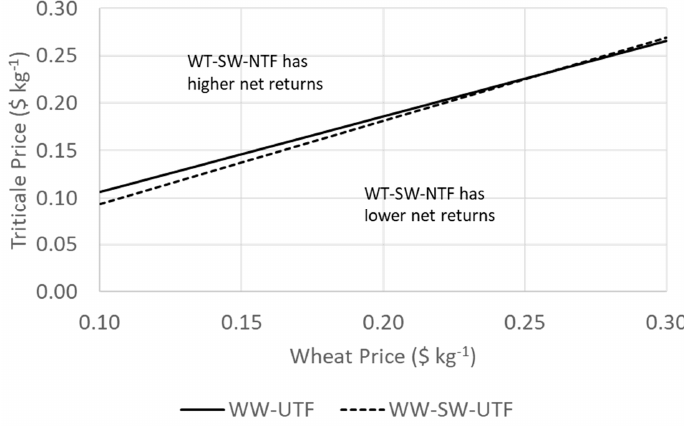
Figure 1. Breakeven winter triticale price as related to wheat price for the WT-SW-NTF rotation to be as profitable as the winter wheat (WW)- spring wheat (SW)-undercutter tillage fallow (UTF) rotation or the WW-UTF rotation. Winter triticale and wheat price combinations above and to the left of the WW-UTF or WW-SW-UTF breakeven lines would have higher average (8-year average) WT-SW-NTF net returns than the respective winter wheat rotation. Winter triticale and wheat price combinations below and to the right of the WW-UTF or WW-SW-UTF breakeven lines would have lower average (8-year average) WT-SW-NTF net returns than the respective winter wheat